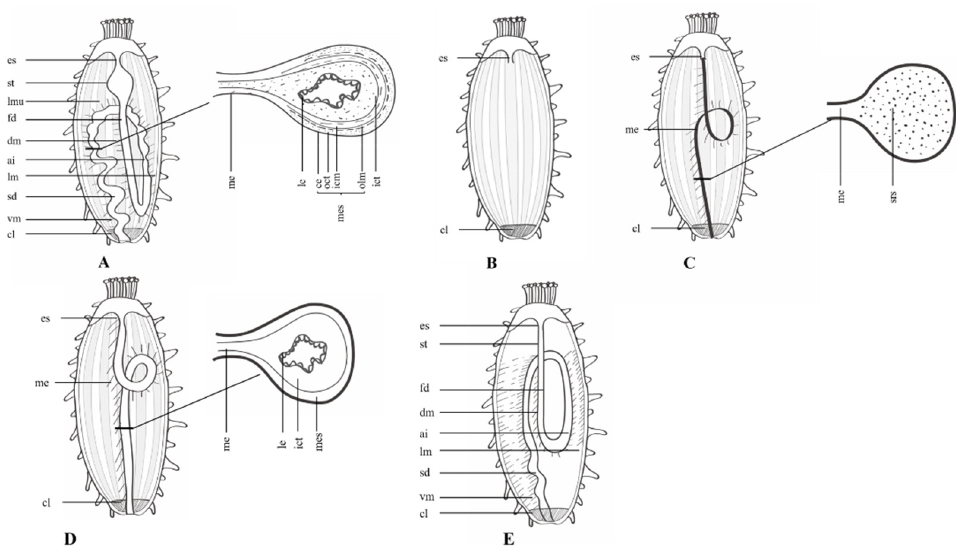
Figure 1. Diagram of the intestinal regeneration pattern of sea cucumbers. ( A ) Structure of the normal sea cucumber digestive tract. ( B ) After evisceration. ( C ) Thickening of the mesentery and formation of a solid rod-shaped structure. ( D ) Lumen formation. ( E ) Differentiation and growth of the newborn intestine. Abbreviations : es, esophagus; st, stomach; fd, first descending intestine; dm, dorsal mesentery; lmu, longitudinal muscle; ai, ascending intestine; lm, lateral mesentery; sd, second descending intestine; vm, ventral mesentery; cl, cloaca; me, mesentery; ce, coelomic epithelium; oct, outer connective tissue; olm, outer longitudinal muscles; icm, inner circular muscles; mes, mesothelium; ict, inner connective tissue; le, luminal epithelium; srs, solid rod-shaped structure. Studies of the histology and cytology of the intestinal wall of sea cucumbers indicate